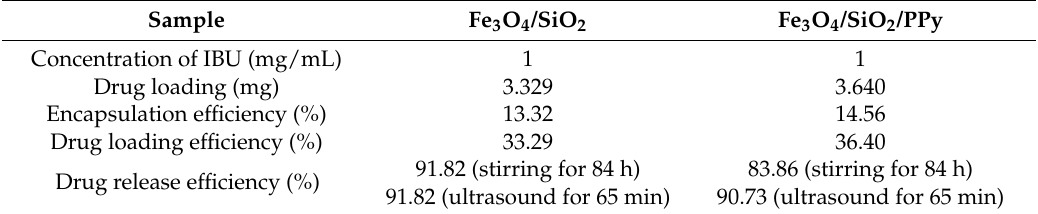
Table 1. Ibuprofen (IBU) loading and release of Fe 3 O 4 /SiO 2 and Fe 3 O 4 /SiO 2 /PPy core-shell composite